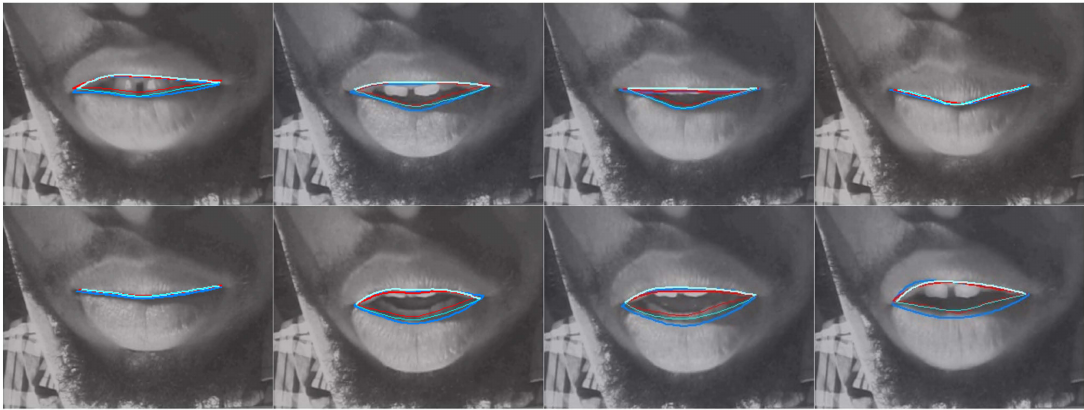
Figure 17. Speaker 12me; blue—hand-label; red—MobileNetV2;